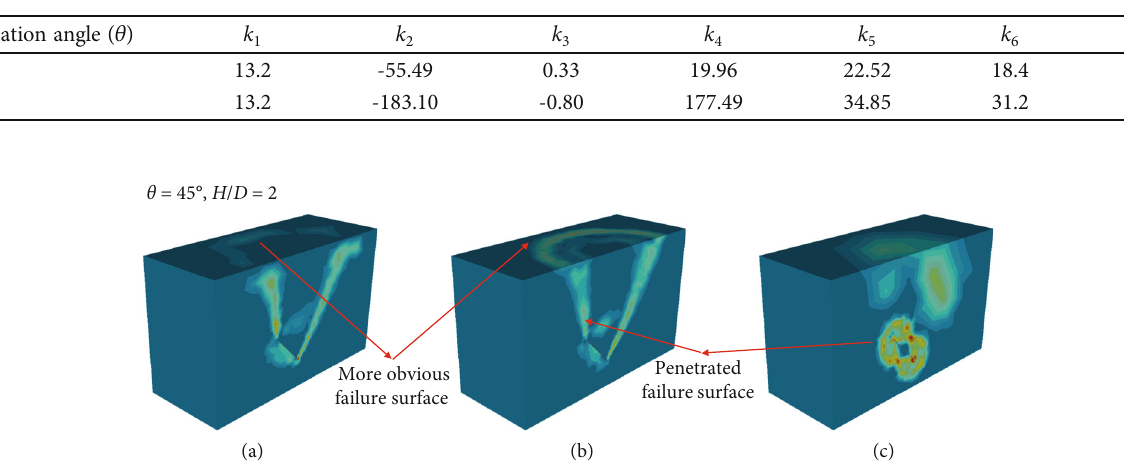
Table 3: Value of regression coe ffi cient.